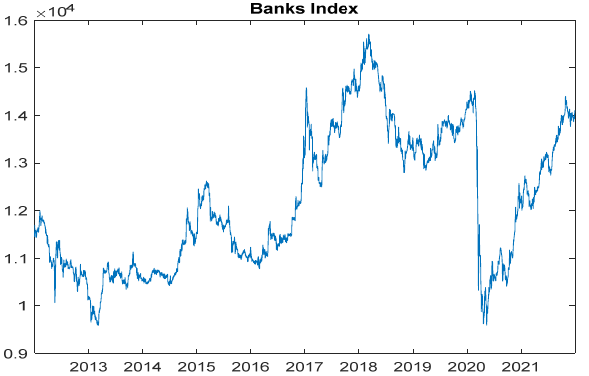
Figure 1. Evolution of the bank index price before and during the COVID-19 crisis.